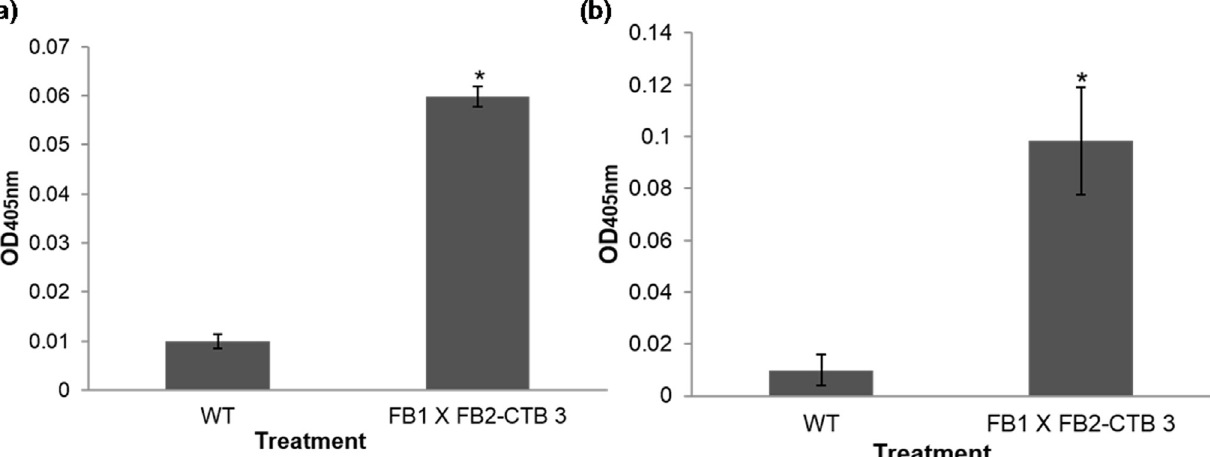
Fig 5. Antibody levels of BALB/c mice immunized with corn smut galls expressing CTB protein. Detection of: (a) anti-CTB IgA antibodies in intestinal washes, and (b) anti-CTB IgG antibodies in sera. Mice immunized with different treatments (biomass from ‘ huitlacoche ’ : FB 1 x FB2-CTB 3 and FB1 x FB2 as control) were bled at day 21, and serum was diluted 1:40. Statistical differences versus the WT group are indicated by an asterisk ( P < 0.05).